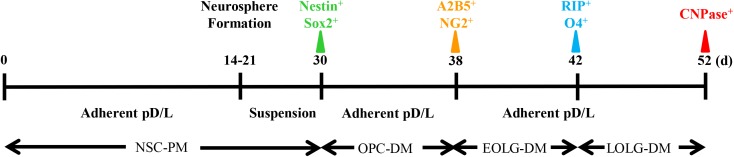
Timeline of oligodendrocyte differentiation. Multicolor triangles represent recommended time points for evaluating the expression of stage-specific markers through immunofluorescence.